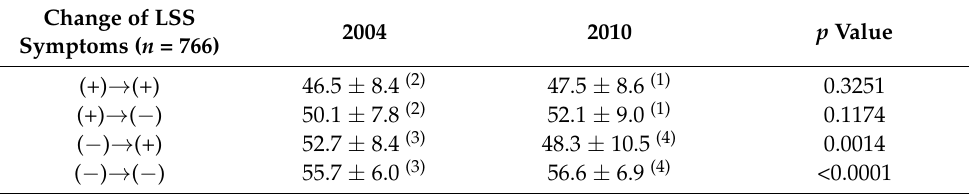
Table 4. Change in RDQ scores of the subjects with/without LSS